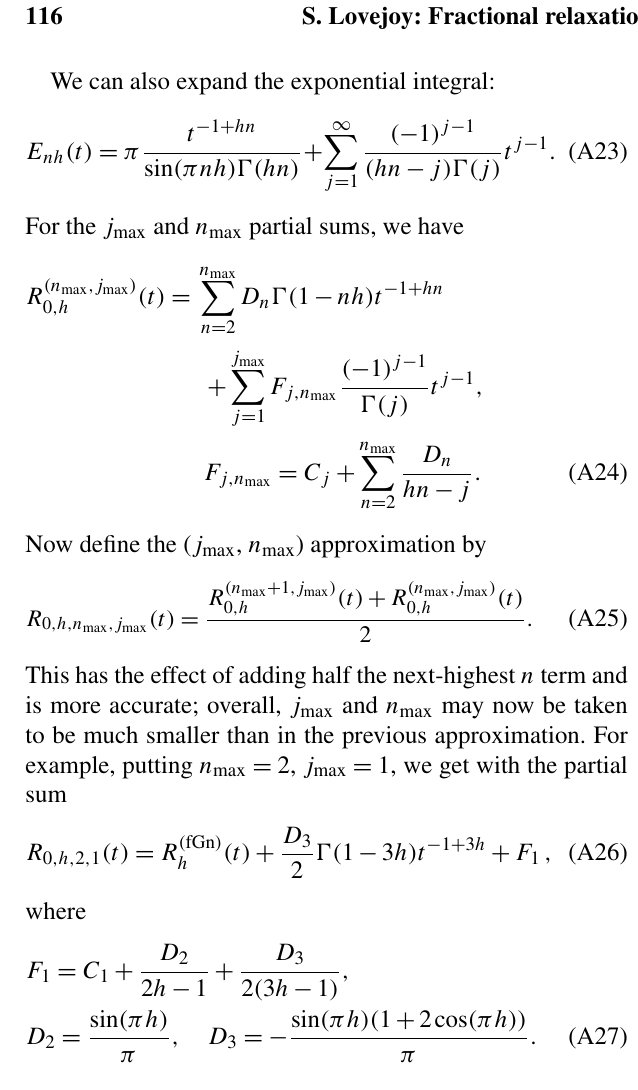
Figure A3. This shows the logarithm of the relative error in the ( 2 , 1 ) approximation with respect to the deviation from (cid:12) (cid:0) R fGn (t) − R 0 ,h, 2 , 1 (t) (cid:1)(cid:14)(cid:0) R fGn (t) − the fGn R h (t) ( r = log 10 (cid:12) 1 − h h (cid:1)(cid:12) R 0 ,h (t) (cid:12) ). For h < 1, t < 0 is of the order ≈ 30%, whereas for h > 1, it of the order 100%. The h = 1 (exponential) curve is not shown, although when t < 0, the error is of order